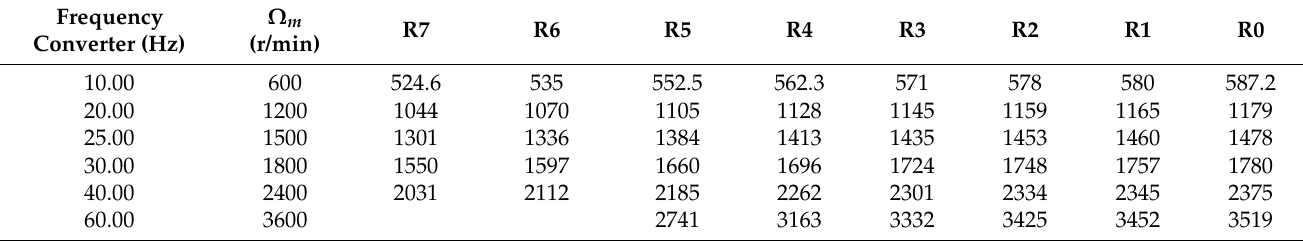
Table 9. DC generator coupled to the motor shaft: measured speed using the tachometer for different values of resistance. Frequency